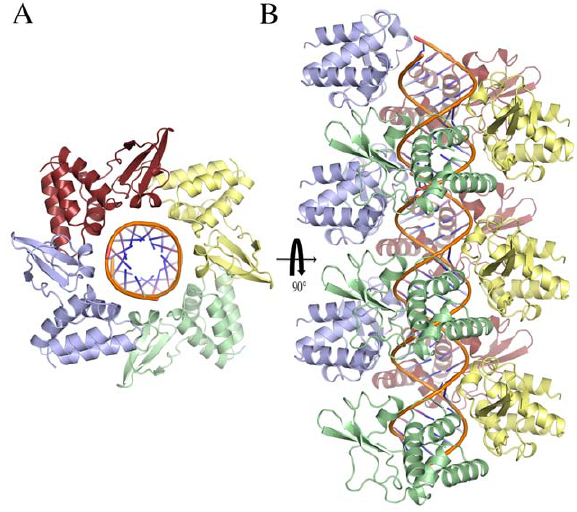
Figure 2. Structure of MARV VP35 in complex with 12-bp dsRNA. (A) Top view of the contents of the asymmetric unit. (B) Side view of the long pseudo-helical arrangement of dsRNA coated by MARV VP35 RBD, as formed by crystal packing. The four monomers in the asymmetric unit are colored pale blue, pale green, pale yellow and ruby, respectively.